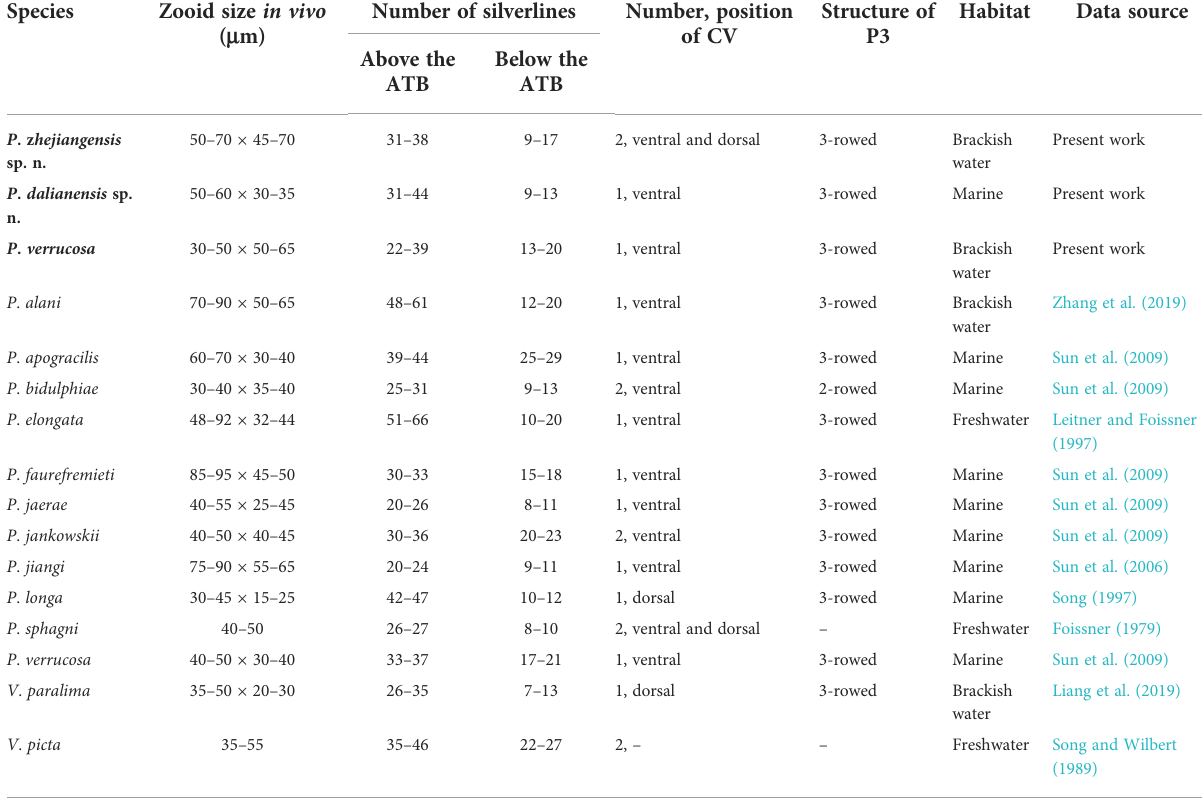
TABLE 3 Morphological comparison of Pseudovorticella zhejiangensis sp. n., Pseudovorticella dalianensis sp. n., and Pseudovorticella verrucosa with their closely related taxa. Species Zooid size in vivo Number of silverlines ( m m) Above the Below the ATB